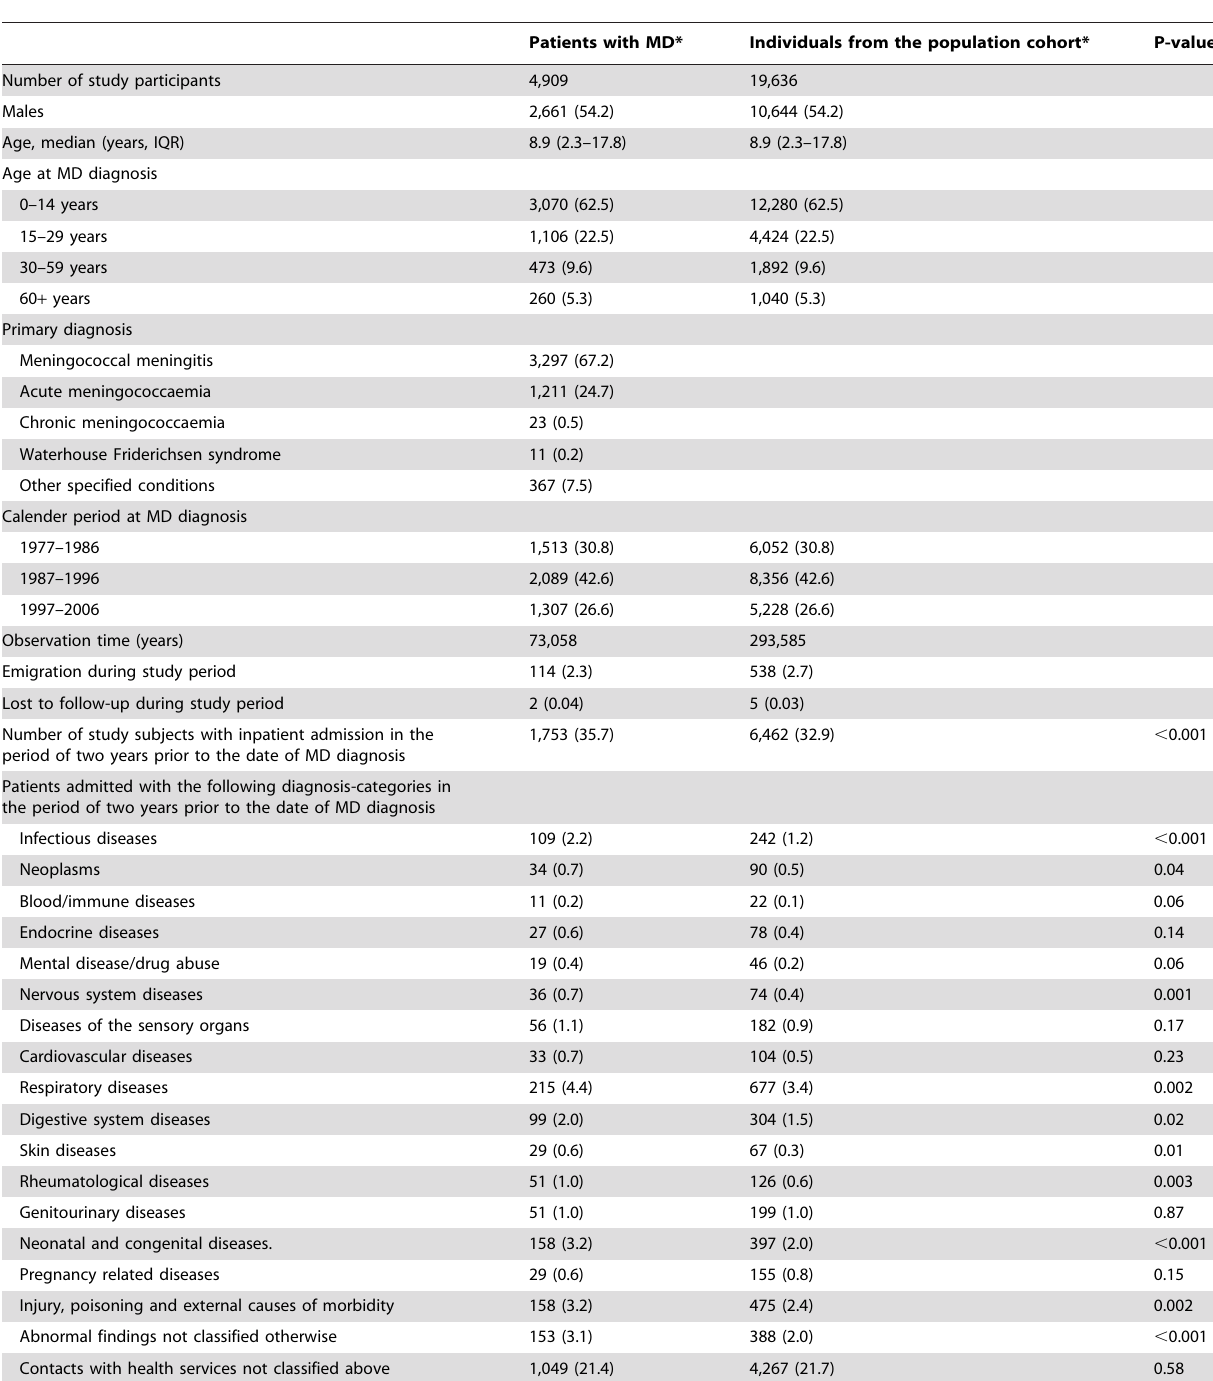
Table 1. Characteristics of meningococcal disease (MD) patients and individuals from the population